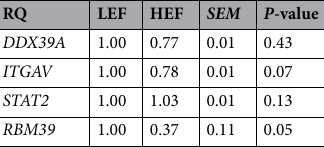
Table 3. Relative gene expression in adipose of high or low- efficient dairy